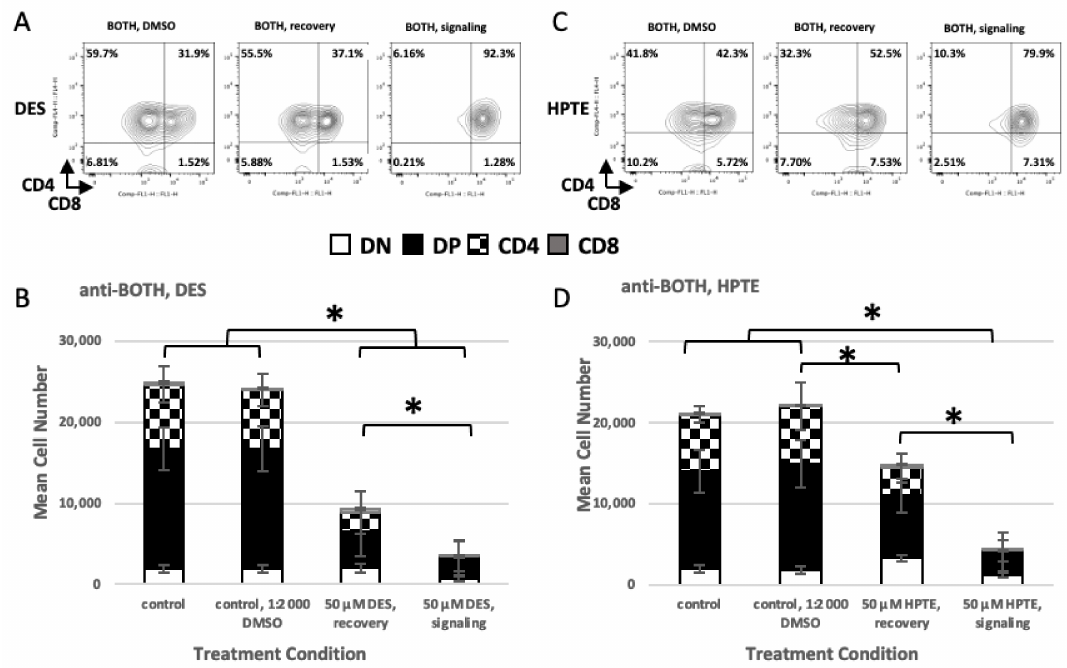
Figure 4. Concurrent TCR-signaling and EDC exposure worsens outcome for differentiating embryonic thymocytes. Embryonic thymocytes were treated with 50 µ M DES ( A , B ) or HPTE ( B ) during the signaling ( A , C —right panel or B , D —fourth bar) or recovery ( A , C —middle panel, B , D —third bar) phases of the differentiation culture. Treated thymocytes were cultured 18–24 h in the presence of the antibody listed above each panel ( A – D ). DES N = 13, HPTE N = 9, * Tukey HSD post-hoc p <